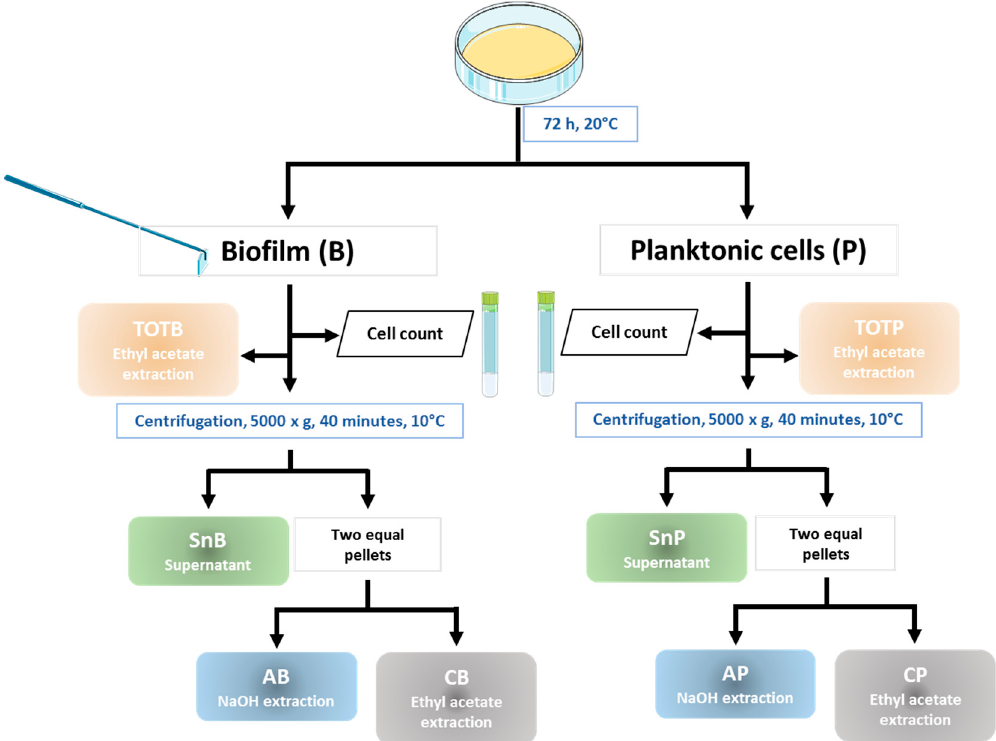
Figure 1. Extraction scheme. TOT is the total extract obtained with ethyl acetate treatment; Sn refers to the broth supernatant; A contains the substances bound to the cell surface that were extracted using NaOH; C refers to the extraction using ethyl acetate on cell pellets. The extract names are followed by B for biofilm cells and P for planktonic cells.